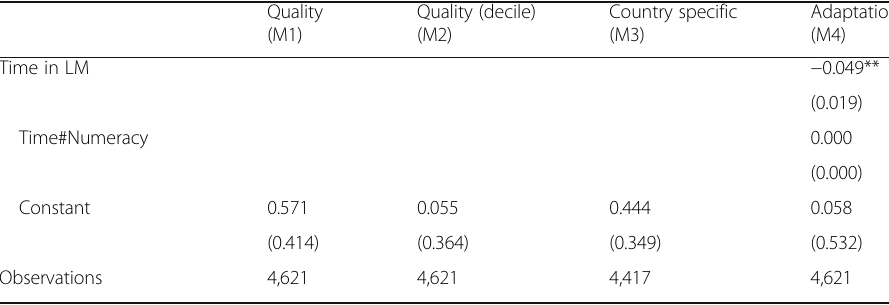
Table 5 Logistic regression on the probability of being unemployed. Explanations for the ethnic gap between natives and immigrants settled in France